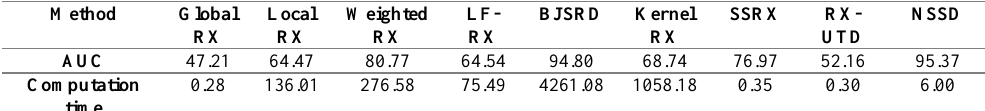
Table 2. Performance of NSSD and other anomaly detectors in terms of AUC and computation time in synthetic image. AUC is area under ROC curve, where a higher value for AUC means a higher detection accuracy.